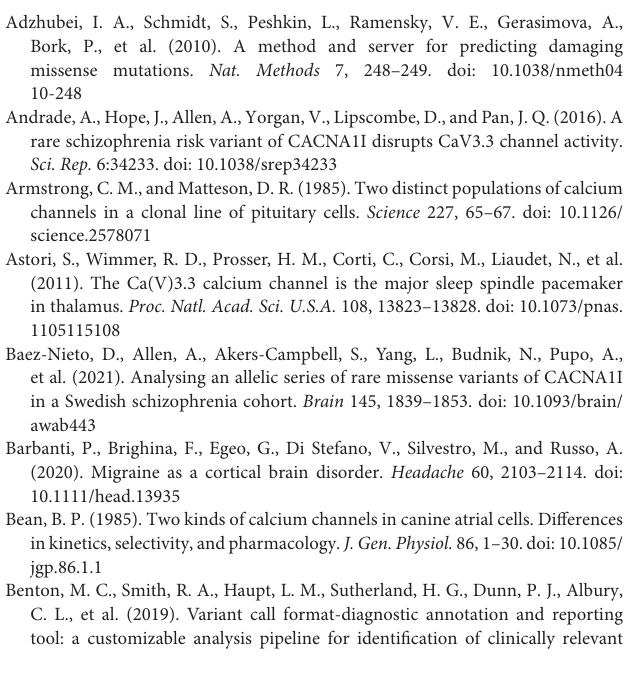
Supplementary Figure 1 | (A) Orthogonal display of immunostained Cav3.3 HM-associated variants. (B) Primary antibody (anti-flag) omitted of WT transfected and stained cells. In (A,B) , green corresponds to Alexa 488 fluorescence and blue is DAPI nuclear counterstain. (C) Current density recorded 24 h (left) and 48 h (right) post-transfection (see section “Materials and Methods”) of individual cells at each time point and their mean ± SEM. Statistical significance for data obtained at each time point was determined by one-way ANOVA with the Dunnett’s multiple comparisons test against Cav3.3 WT. p ≤ 0.0001 ( ∗∗∗∗ ), p ≤ 0.005 ( ∗∗ ), or p ≤ 0.05 ( ∗